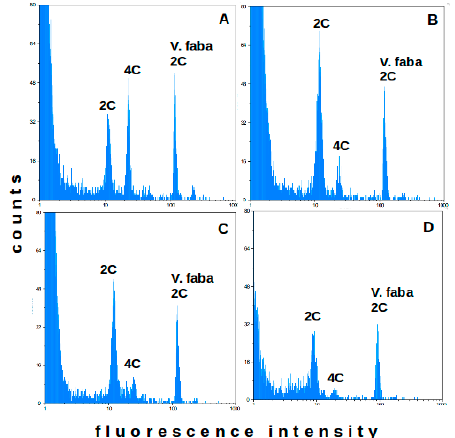
Figure 2. Flow cytometry histograms of rooibos radicles ( A ) and cotyledons ( B ), as well as fresh leaves ( C ) and silica-dried leaves ( D ) from two-months-old commercial rooibos seedlings. 2C (G0/G1 phase), 4C (G2 phase) and reference standard ( Vicia faba; 2C = 26.66 pg) 2C peaks are shown. ( n = 10).